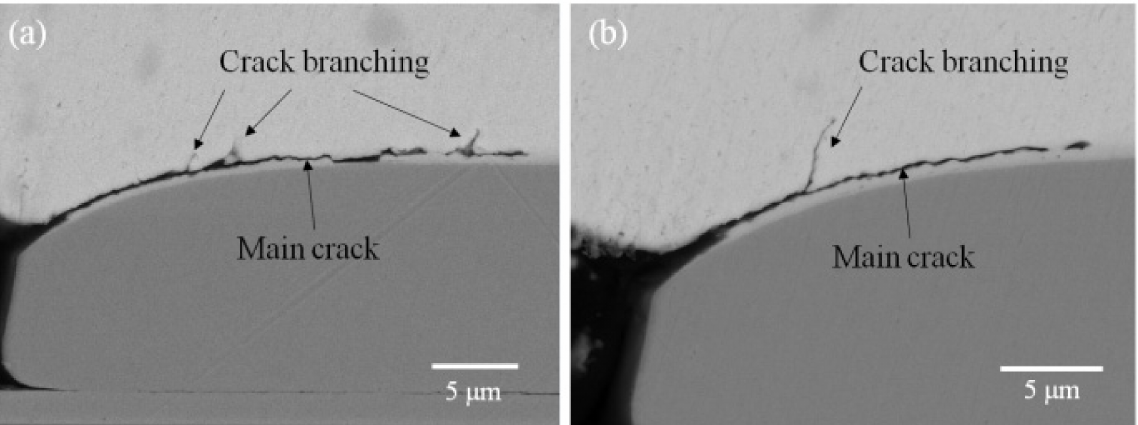
Figure 15. Crack branching during the initial stage of the drop test: ( a ) The minute crack branching increase as the fracture progresses; ( b ) The first crack